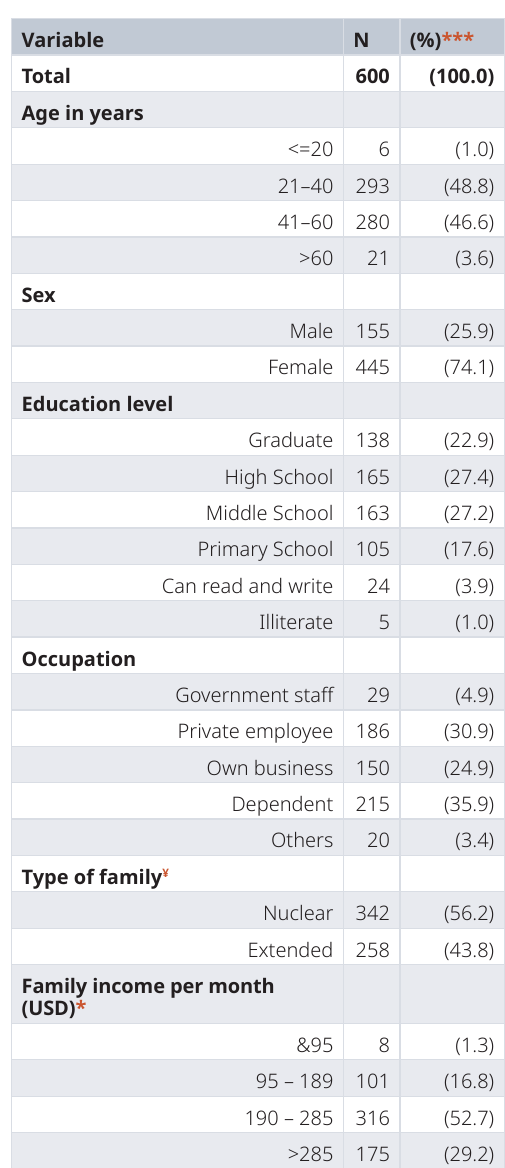
Table 1. Socio-demographic characteristics of participants * in the Japanese encephalitis survey, Yangon region, Myanmar